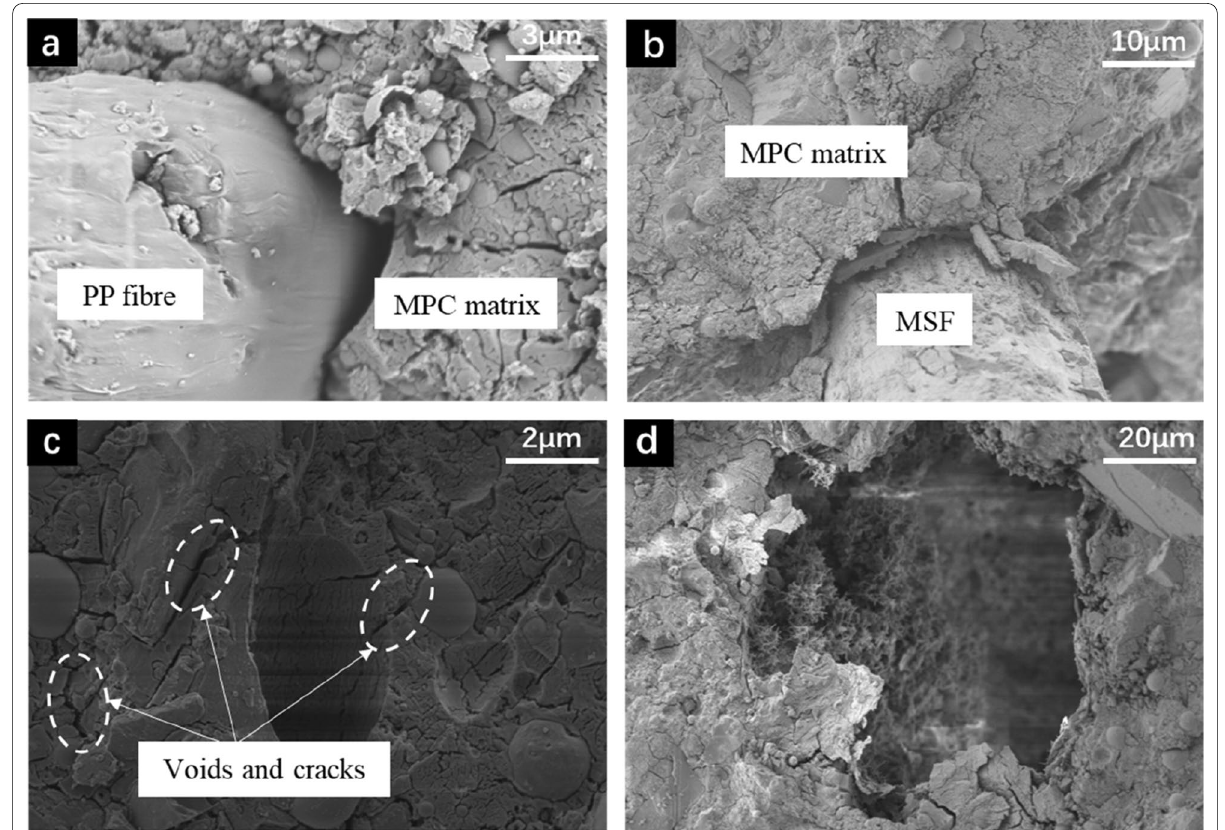
Fig. 9 Microstructure of the interface of a PP fibre and b MSF with MPC matrix; pull-out hole of c PP fibre and d